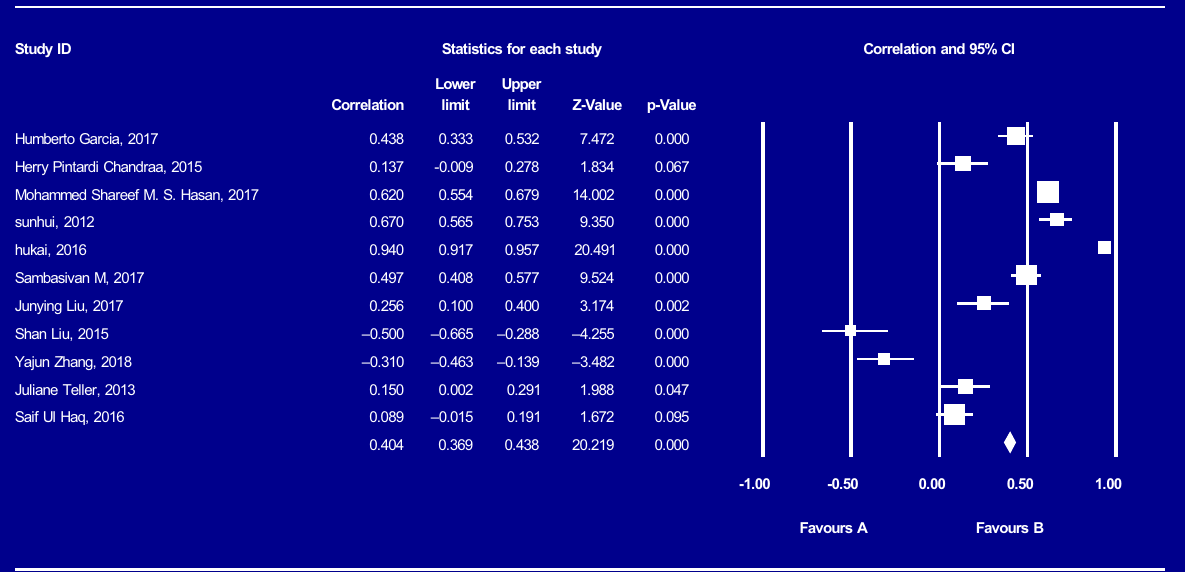
Figure A4. Results of meta-analysis